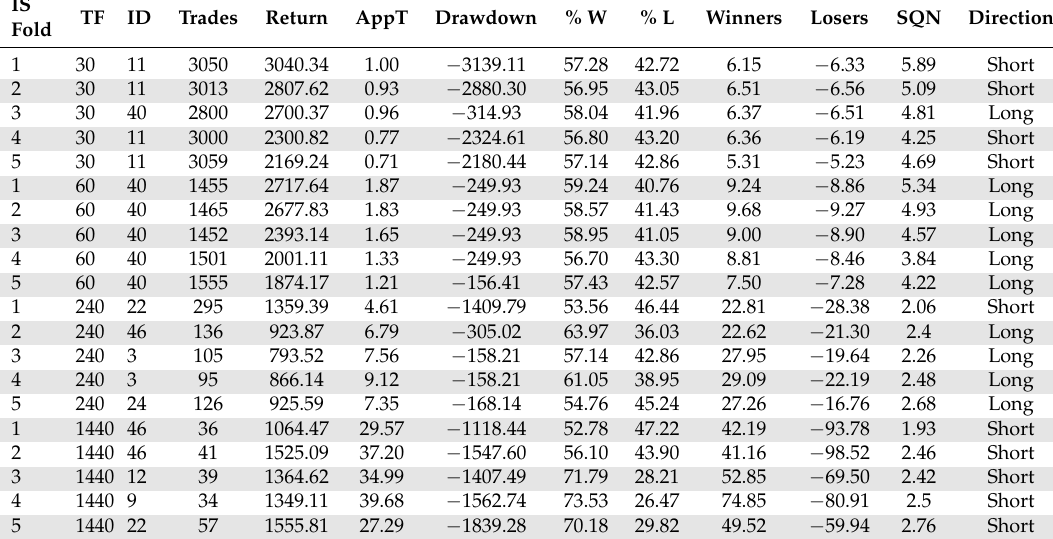
Table 4. In-sample strategy results considering all different timeframes and all five in-sample periods. Each in-sample period comprises approximately eight years of data. The column ID says which candlestick performs best for that period of historical data, while the Direction columns tells us whether we should go short-only or long-only to obtain the results shown.